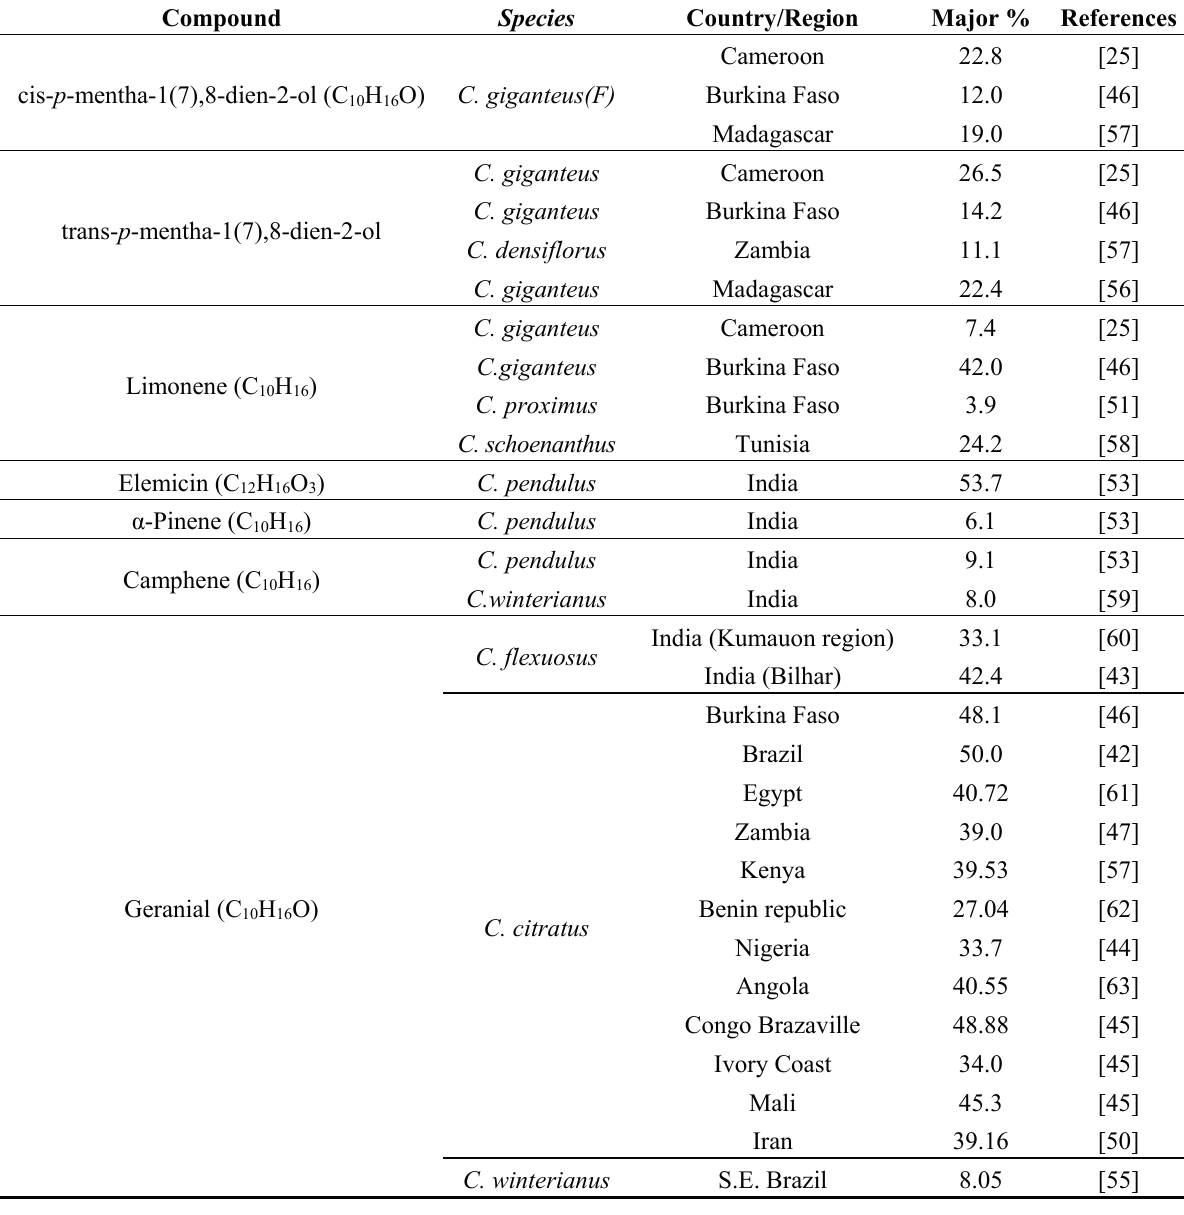
Table 2. Major components observed in some Cymbopogon